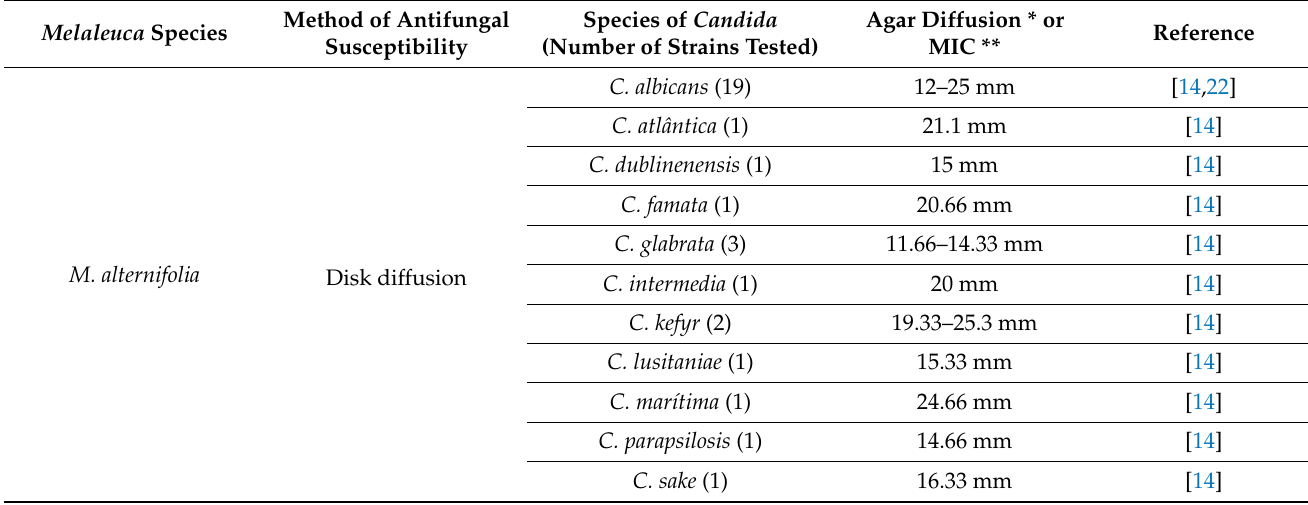
Table 1. In vitro antifungal activities of Melaleuca spp. essential oils tested against Candida species according to different